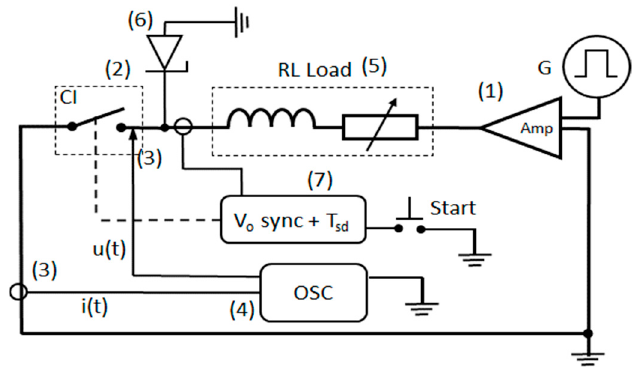
Figure 2. Testing stand diagram.